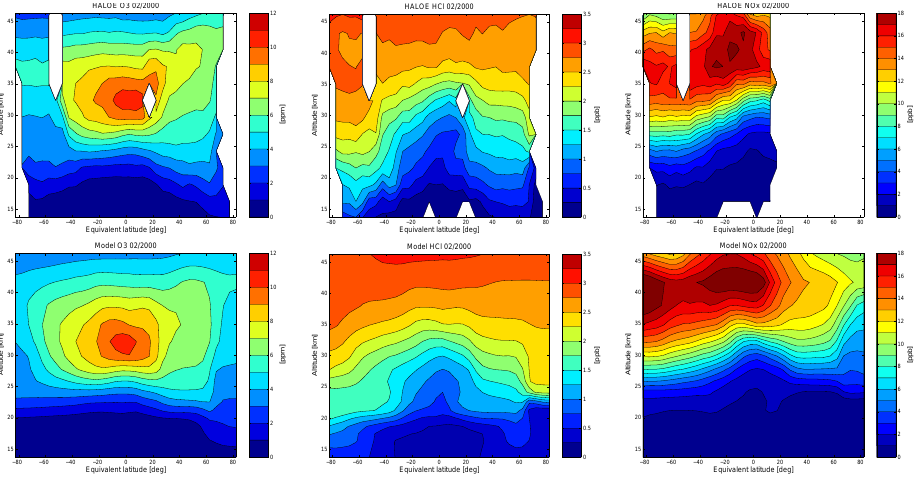
Fig. 11. Zonal and monthly mean mixing ratios for O 3 , HCl and NO x as a function of pressure altitude and equivalent latitude for Febru- Fig. 111. Zonal and monthly mean mixing ratios for O 3 , HCl and ary 2000. Top: HALOE measurements, bottom: modeled NO x as a function of pressure altitude and equivalent latitude for February 2000. Top: HALOE measurements, bottom: modeled val- ues.